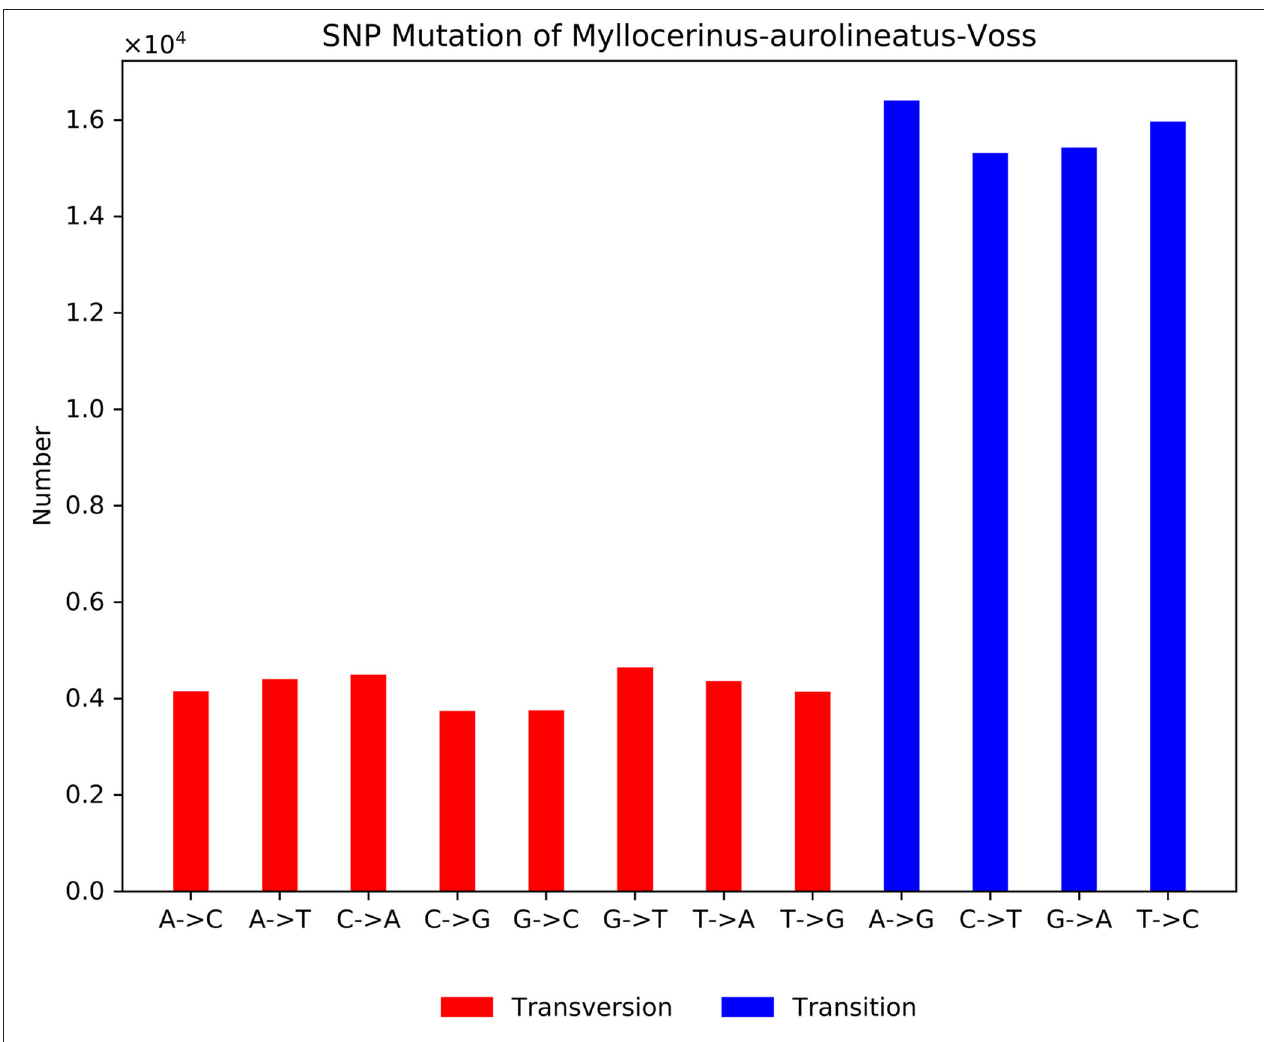
FIGURE 8 | Classification of SNPs identified in the M. aurolineatus